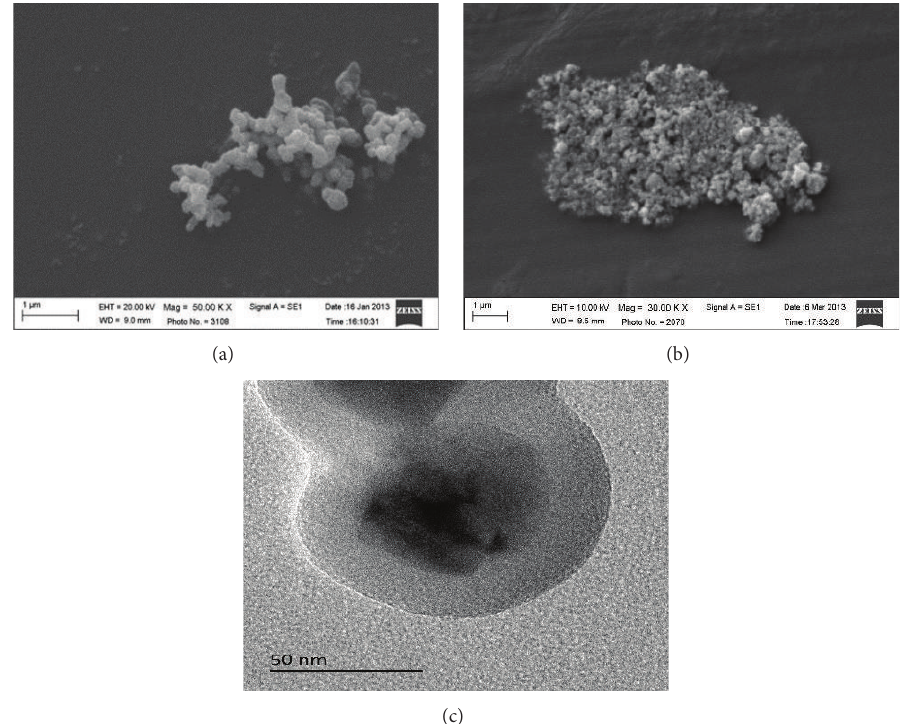
Figure 1: The surface morphology of freshly prepared NZVI@SiO 2 -NH 2 and NZVI: (a) SEM image of the NZVI@SiO 2 -NH 2 , (b) SEM image of the NZVI, and (c) TEM image of the NZVI@SiO 2 -NH 2 .